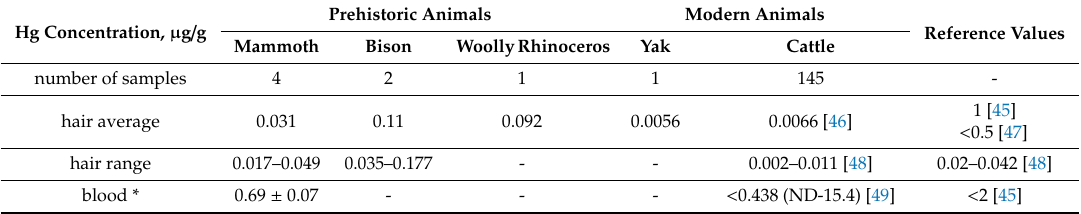
Table 4. Hg concentrations in hair of modern and prehistoric animals and reference values. Hg Concentration, µ g / g